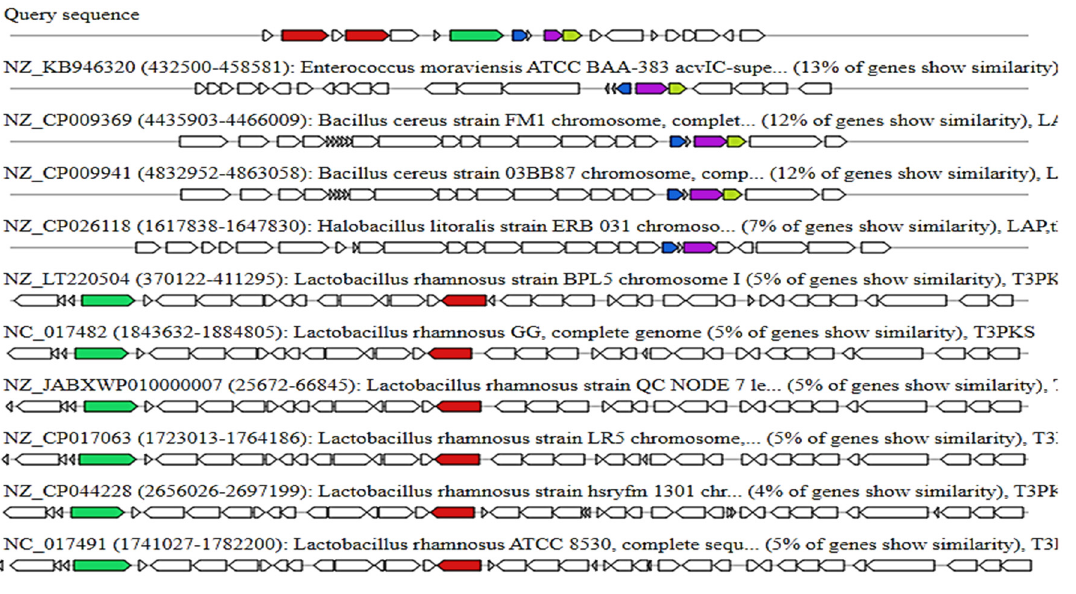
Figure 5. Prediction of Exopolysaccharides (EPS) in red by antiSMASH along with the genomic comparison of Lp YW11 with other strains of Lactiplantibacillus plantarum .